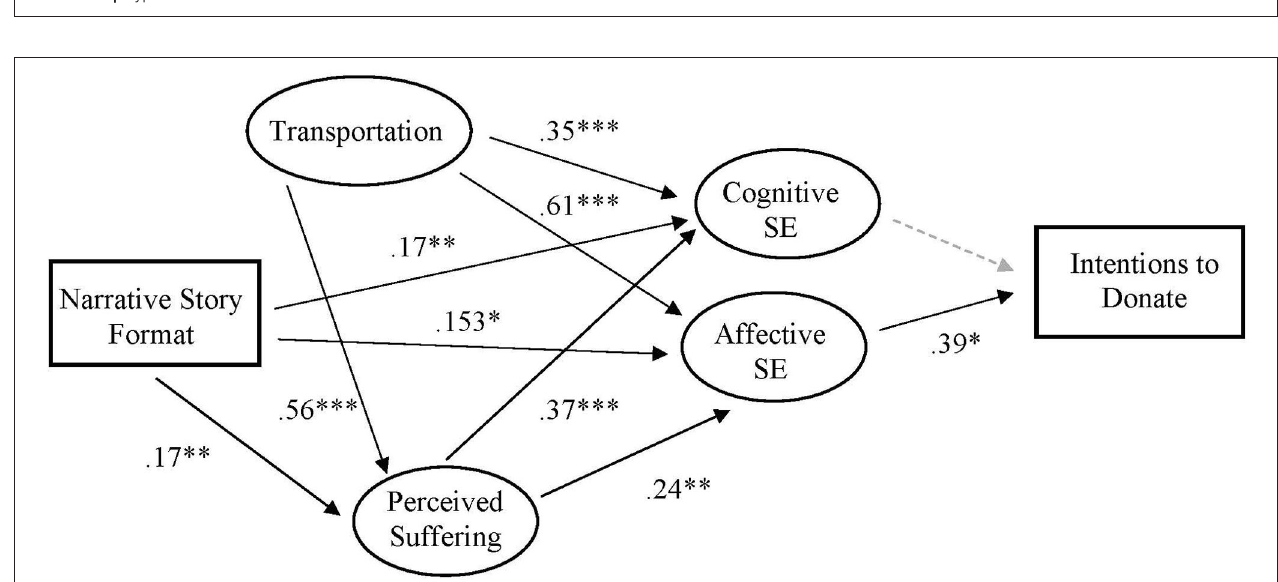
FIGURE 2 | Final path model. *P < 0.05, **P < 0.01, ***P < 0.001. Solid black lines indicate significant direct effects (P < 0.05); insignificant paths are indicated with dashed